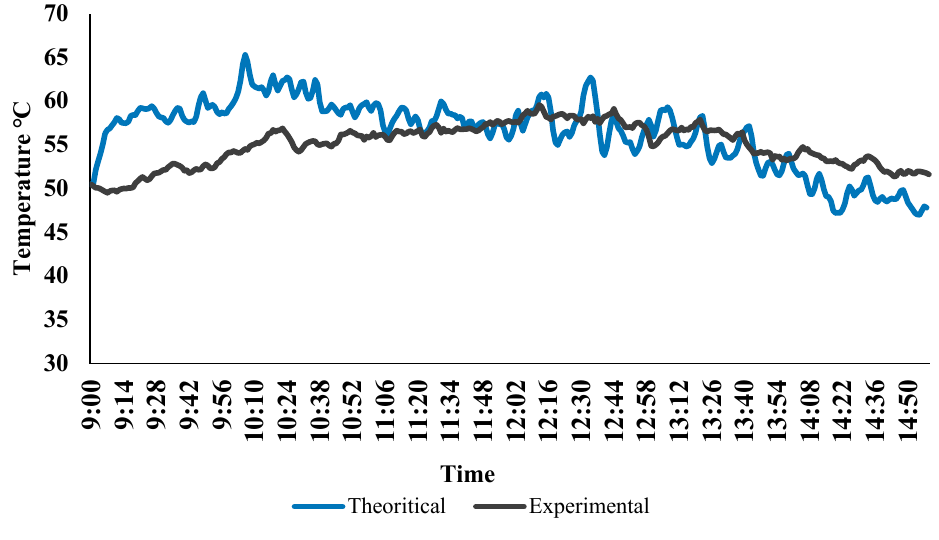
Figure 3. Comparison between theoretical and experimental result.